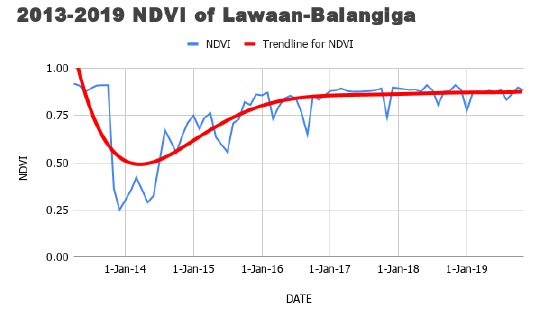
Figure 4. NDVI Time series chart of Lawaan - Balangiga mangroves